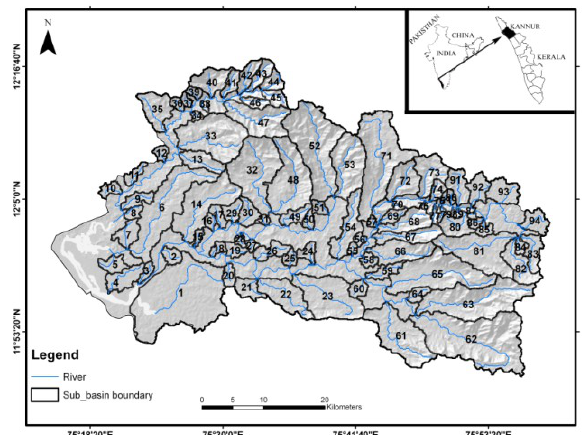
Figure 1. Map showing location and sub-basins of valapattanam river.